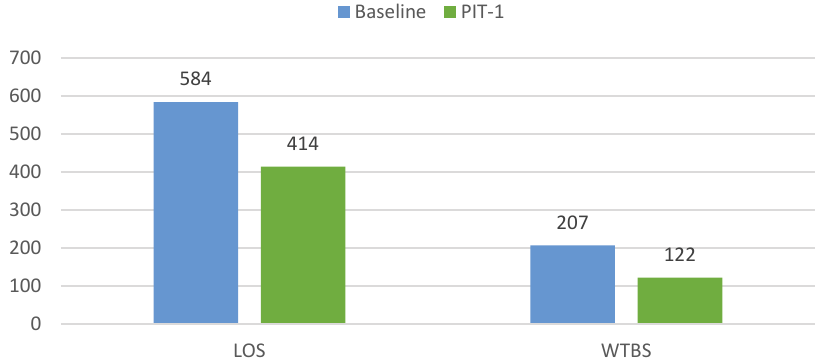
Fig. 7 . Results of patient average waiting time and throughput time by using PIT-1 comparing with the baseline